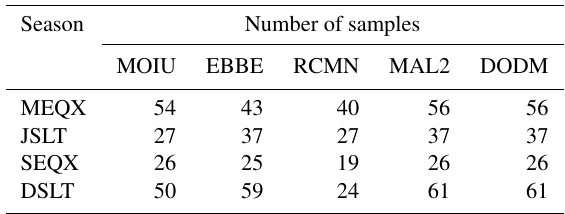
Table 3. Number of samples used to compute correlation coeffi-